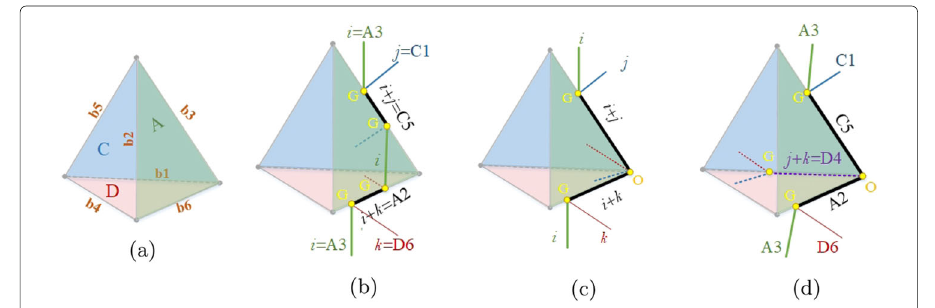
Fig. 10 a The slip planes (A, C, D) and Burgers vectors ( b 1 , ··· , b 6 ) in the SB notation. Note that the A, B, C, D labels in the SB notation do not match those in the Thompson tetrahedron notation. b A dislocation on slip system i =D6 involved in two glissile reactions with slip systems j =A3 and k =C1: D6+A3=A2 and D6+C1=D4. G refers to the type of the nodes. c The two glissile junctions A2 and C5 meet at the apex of the tetrahedron, forming a 4-arm node. This node is O-type. d The 4-arm node splits into two 3-arm nodes connected by a dislocation link on slip system D4. The node on the apex of the tetrahedron is connected to three 60 ◦ dislocations on slip systems A2, D4 and